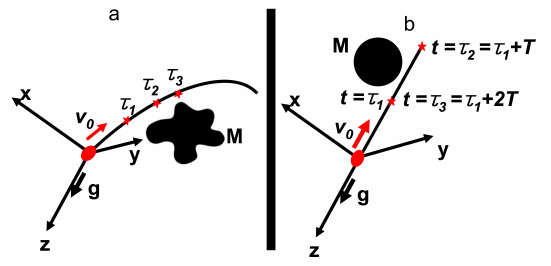
Figure 1. Schematic representation of an atom interferometer in the presence of a test mass M . The atom cloud of the interferometer is launched at t = 0 with velocity v 0 and interacts with Raman pulses at times t = τ 1 , t = τ 2 ≡ τ 1 + T and t = τ 3 ≡ τ 1 + 2 T , indicated by the stars in the diagram. ( a ) A generic interferometer; ( b ) the fountain geometry used for the numerical calculations. In this case, the mass is a point mass or spherical mass having radius y min that is centered at position ( x , y , z ) = ( x m 0 , y m 0 , z m 0 ) ( 1 ) ( t ) = 0) and a test mass moving at constant velocity at time t = 0. The case of a stationary test mass ( x m ( 2 ) ( t ) = x + v m t ) are considered. The modification of the signal produced by the test mass ( x m 0 m